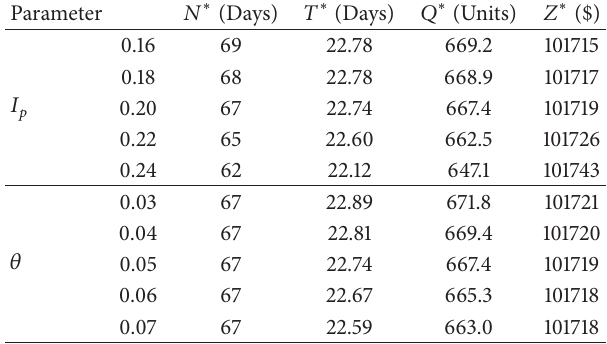
Table 2: Sensitive analysis of Example 14 for parameters 𝐼 𝑝 and 𝜃 .